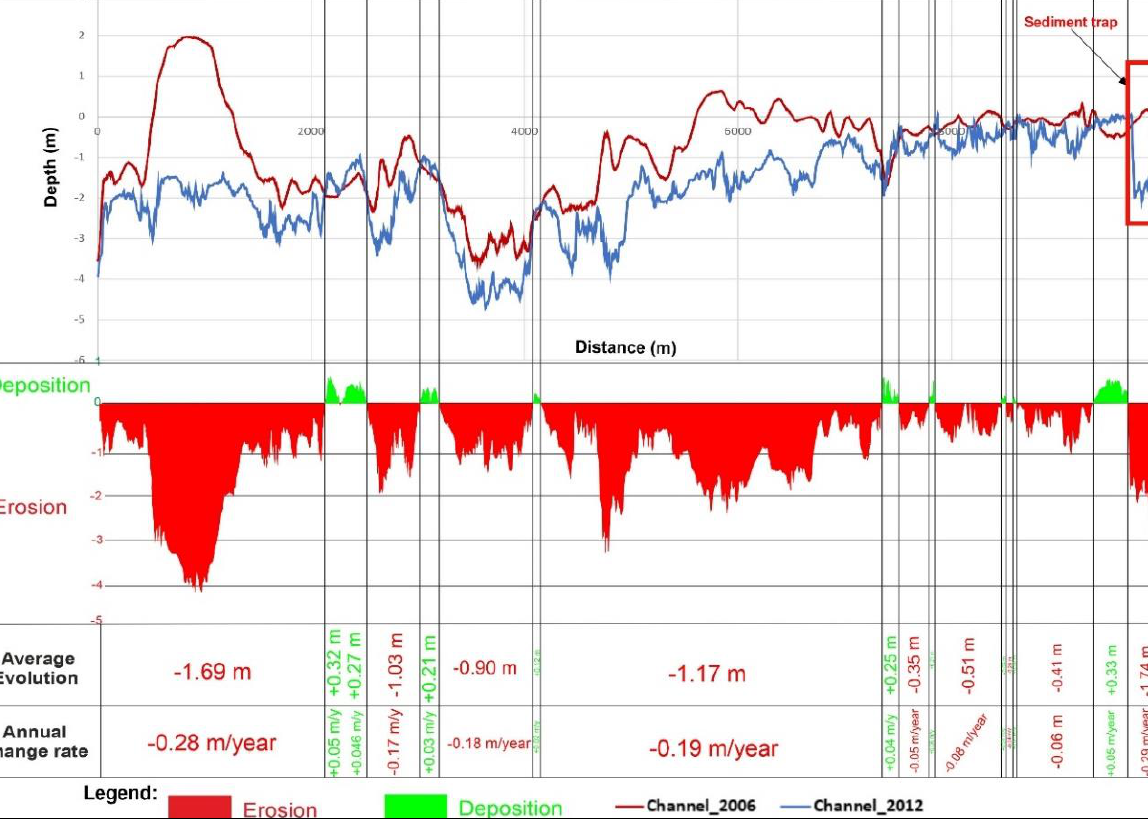
Figure 8. Cross section of the Oualidia lagoon’s channel